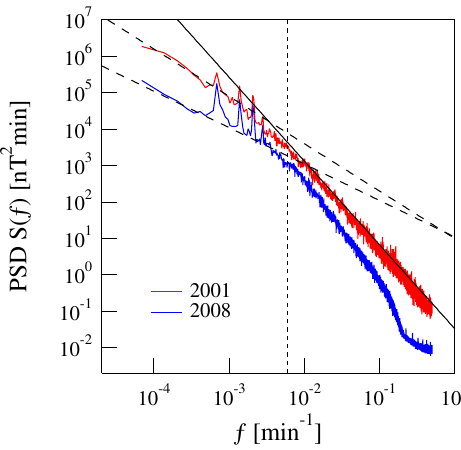
Fig. 8. The dependence of the kurtosis κ of the magnetic field increments ( δ H ( τ ) ) on the timescales τ for the two selected periods.